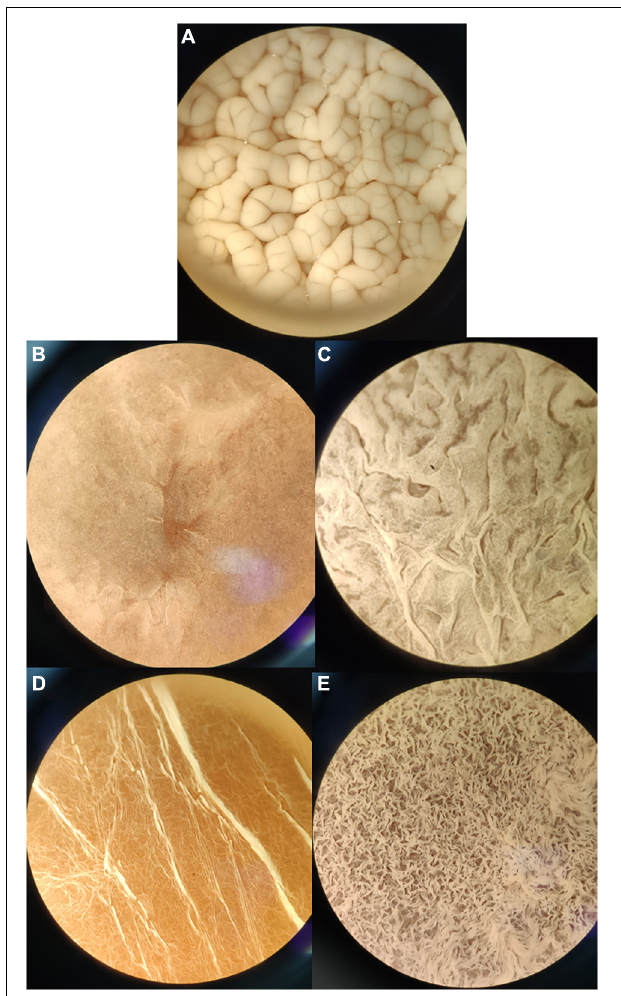
FIGURE 3 | Biofilm formation by different axenic yeast cultures at 10 × once the biofilm covered the whole medium surface. (A) S. cerevisiae flor in wine after 25 days of inoculum; (B) Pichia manshurica in YPD after 5 days; (C) Trichosporon ashaii in YPD after 5 days; (D) W. anomalus in YPD after 5 days. (E) Non- Saccharomyces sp. in YPD after 5